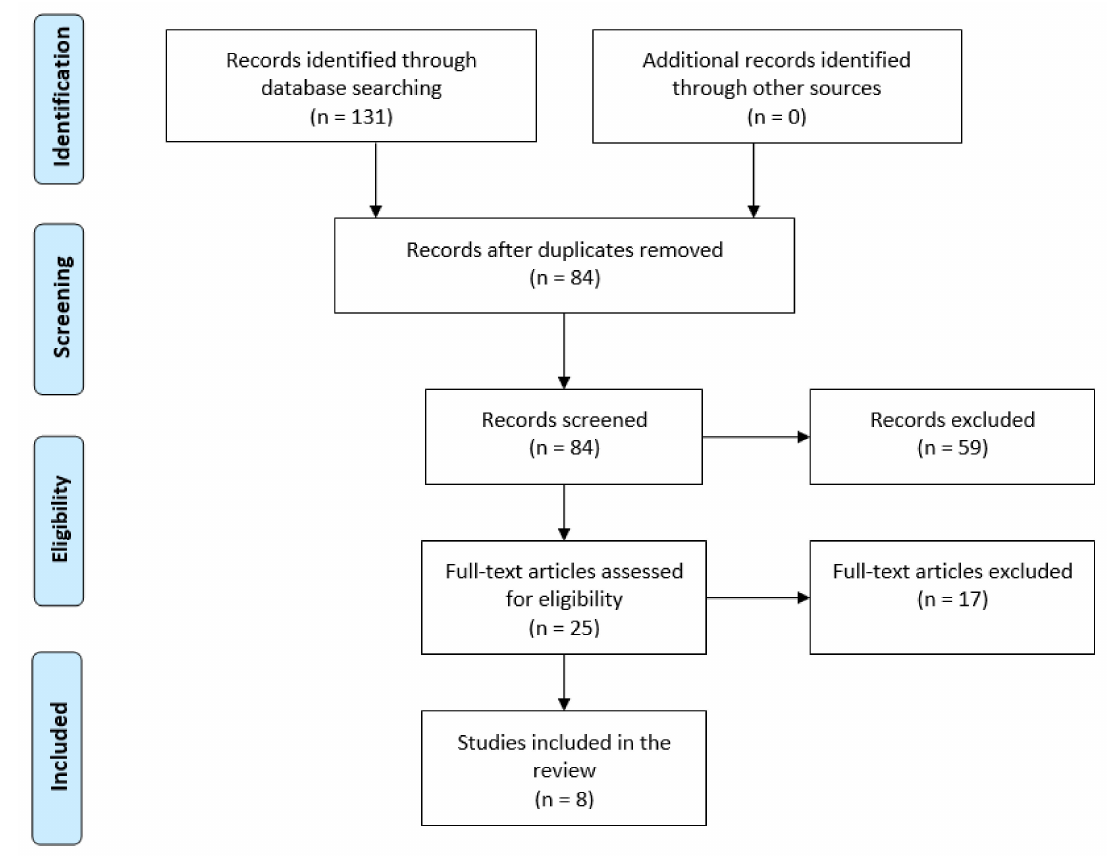
Figure 2. Flow chart of search